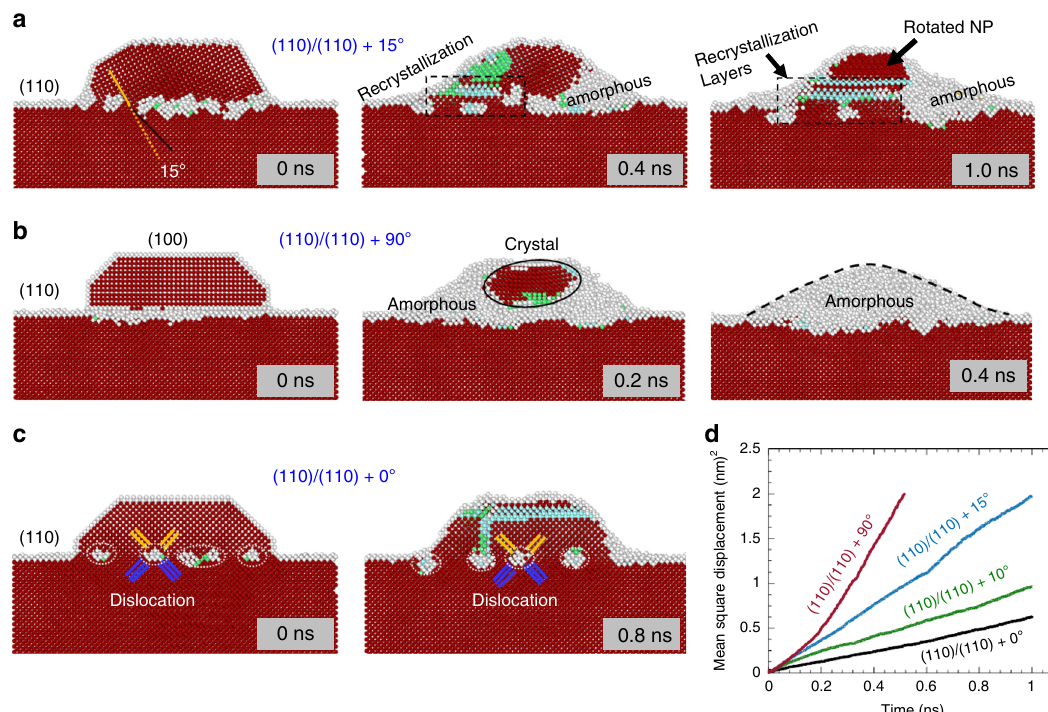
Fig. 5 MD simulations of stability of supported Au clusters at 900 K. a – c Atomic structure evolution in Au clusters that are misaligned with the substrate by 15°, 90°, and 0°, respectively, between the (110) lattice planes of the cluster and substrate (Supplementary Movies 6 – 8). d The MSD of atoms in the clusters measured as a function of time with the various interface orientations. The red, gray, green, and light blue spheres represent the atoms with FCC, disordered or unknown, BCC, and HCP